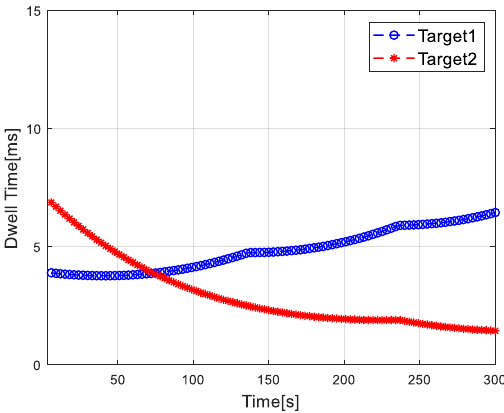
Figure 3. Dwell time of radar network on target.